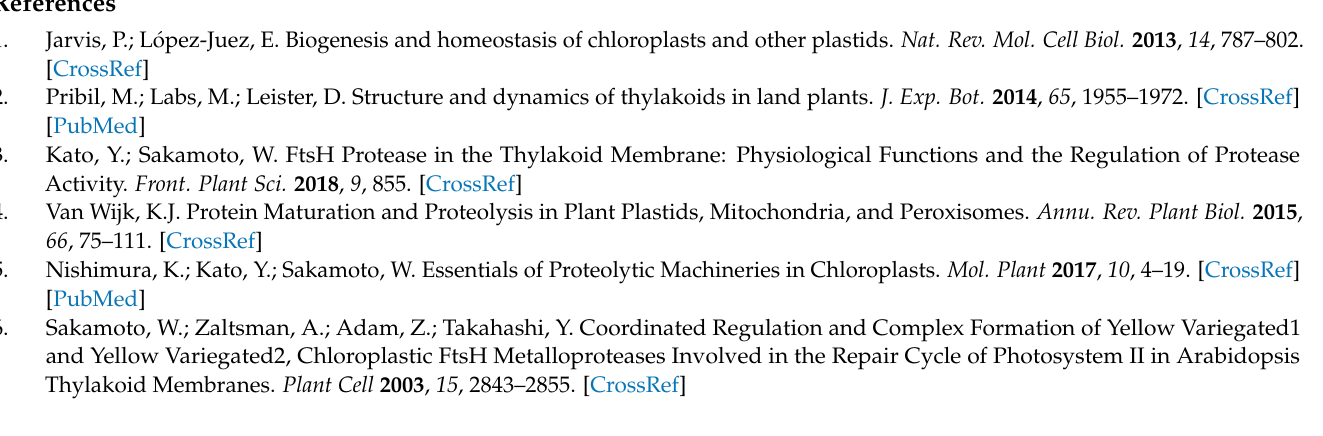
to the proteotoxic stresses, related to Figures 2 and 5. Each bar graph shows protein abundances shown as normalized emPAI-based quantitative values (the average of the two replicates +/